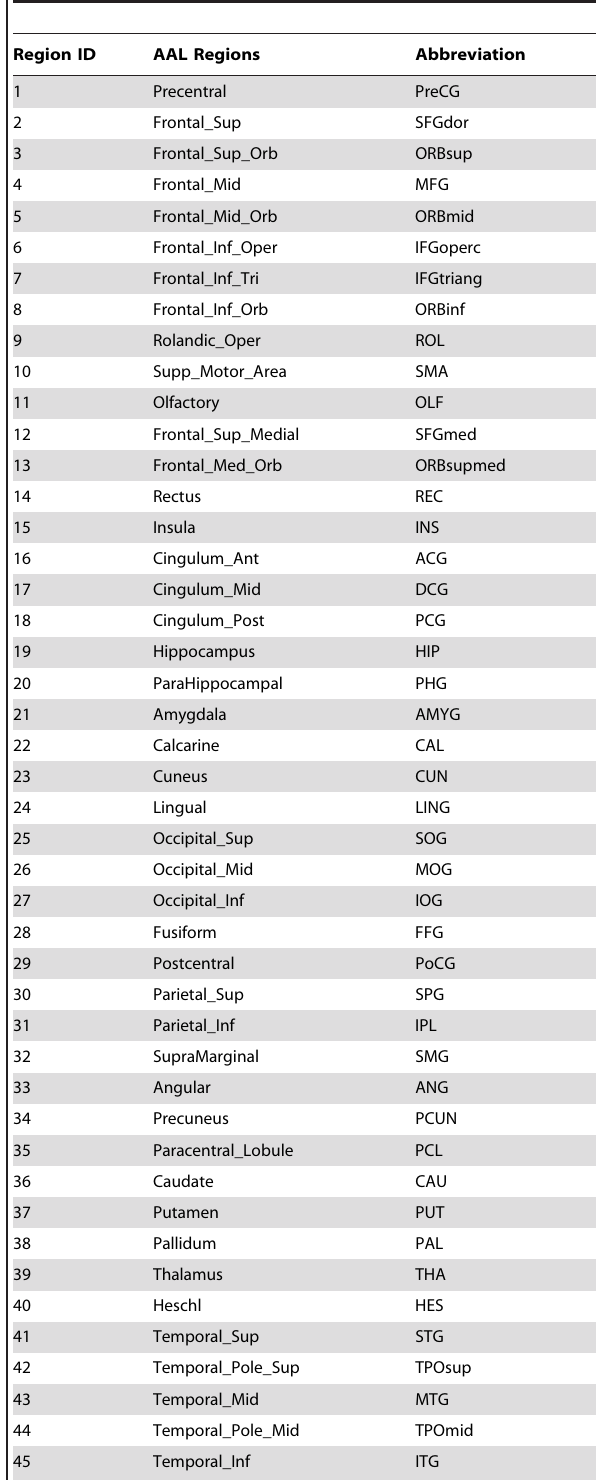
Table 2. The abbreviations of AAL regions except the